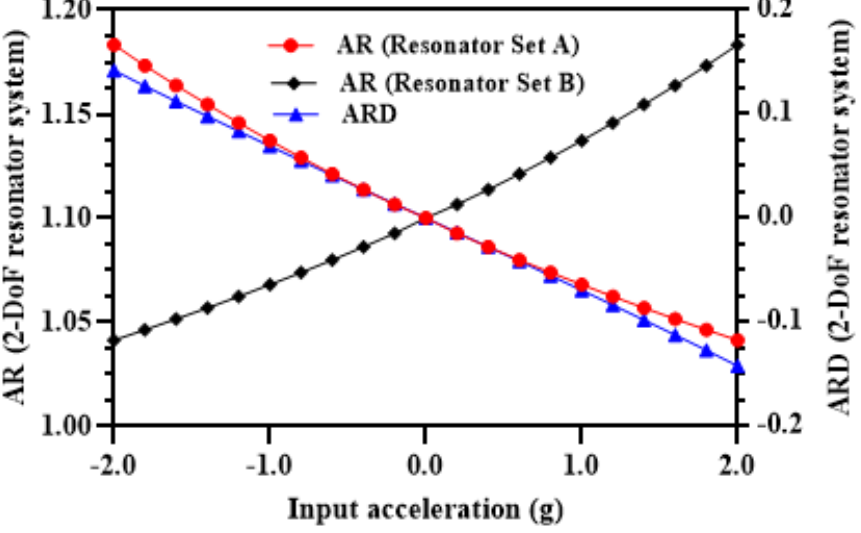
Figure 17. The amplitude ratio and amplitude ratio difference of 2-DoF weakly coupled resonators based MEMS based MEMS accelerometer.